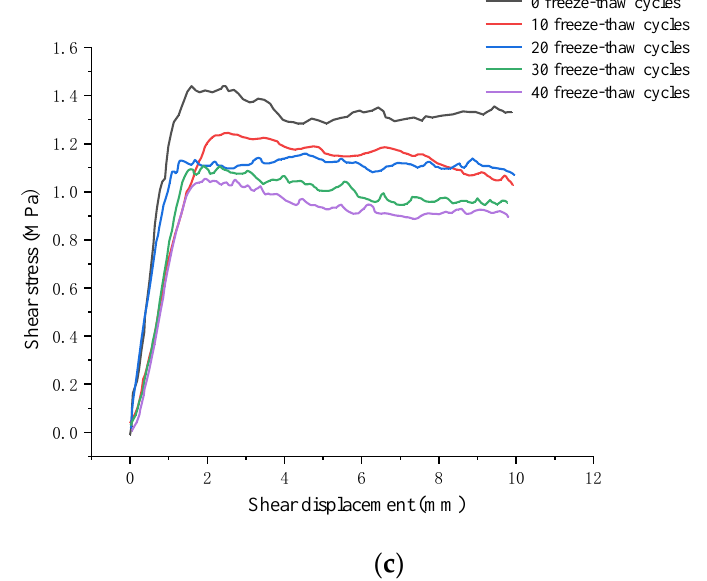
Figure 7. Shear stress-displacement curve of the freeze-thaw jointed rock specimen. ( a ) The first shear experiment. ( b ) The second shear experiment. ( c ) The third shear experiment.